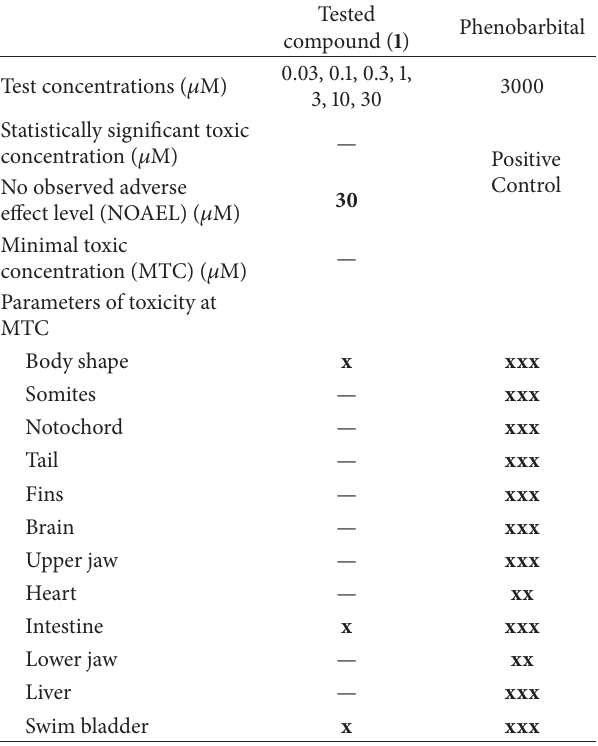
Table 1: Results of zebrafish embryo toxicity study with toxicolog- ical indices and major organs/systems affected in positive control and at MTC in test compounds (—: no effect, x : slightly toxic, xx : moderately toxic, and xxx : severely